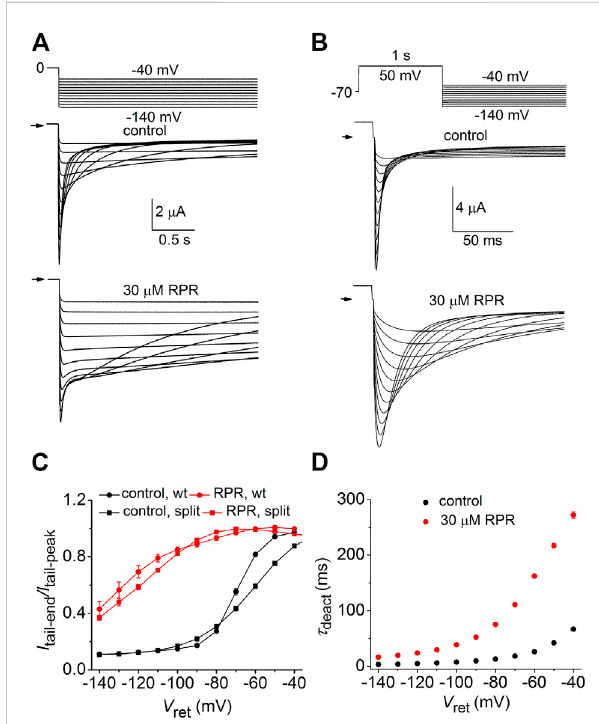
FIGURE 3 RPR slows deactivation rate of WT and split hERG1a channels. (A) Voltage pulseprotocoland corresponding tailcurrentsrecordedfrom an oocyte expressing WT hERG1a channels before (control) and after treatment with 30 µM RPR ( n = 5). From a holding potential of 0 mV, the cell was repolarized for 2.5 s to a variable V ret . Horizontal arrows indicate zero current level. (B) Voltage pulse protocol and corresponding tail currents recorded from a single oocyte expressing splithERG1a channels before(control)and aftertreatmentwith 30 µM RPR ( n = 7). (C) Plot of I tail-end / I tail-peak for WT channels ( n = 5) and split hERG1a channels ( n = 7) under control conditions and after treatment of oocytes with 30 µM RPR of split hERG1 channel ( n = 7). I tail-end was measured at 2.5 s for WT channel currents and at 25 m for the more rapidly deactivating split hERG1a channel currents. (D) RPR slowed n = 7; p < 0.0001, 2-way τ deact of split hERG1a channel currents ( ANOVA). For all experiments, oocytes were bathed in the high K + (104 mM) extracellular